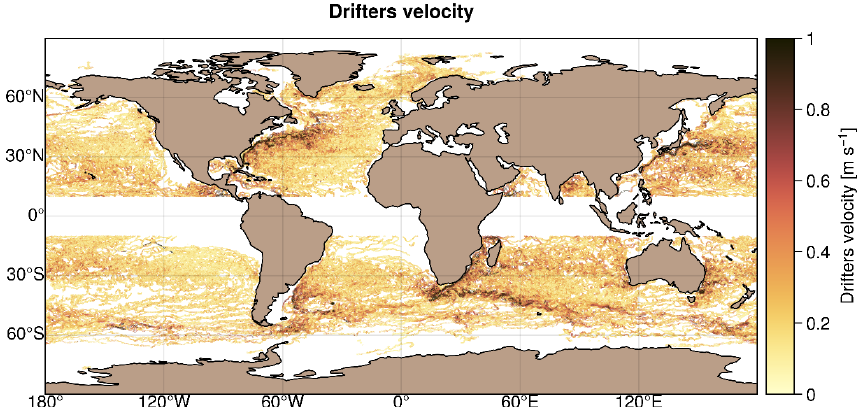
Figure 3. Example of the drifter’s trajectory coverage for the period 1 January 2019 to 31 December 2019. Colour scale represents the velocity amplitude in metres per second (ms − 1